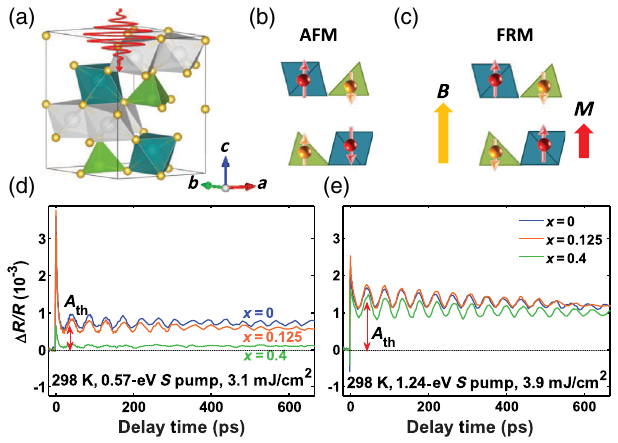
FIG. 2. (a) A schematic diagram of the unit cell of Fe 2 Mo 3 O 8 with Fe 2 þ ions in the green shaded oxygen octahedrons ( O site) and blue shaded oxygen tetrahedrons ( T site). The Mo 4 þ ions are located within the gray shaded oxygen octahedrons. (b),(c) Each illustration displays four sublattices in a magnetic basis for the AFM phase (b) and ferrimagnetic (FRM) phase (c). (d),(e) Time- resolved reflectivity change Δ R=R measured at room temperature with probe light centered at approximately 0.86 eV. The absorp- tion A (see text for the definition) is comparable for different Zn th Þ concentrations x in ð Fe 1 − Zn 2 Mo 3 O 8 when the pump photon x x energy is above 1 eV. However, A is greatly reduced with th excitation energies of approximately 0.5 – 0.6 eV for an x ¼ 0 . 4 sample, which replaces 80% of Fe 2 þ ions on the T site. The oscillatory behavior in Δ R=R is due to the Brillouin scattering of the probe light arising from a propagation of coherent acoustic strain generated by laser heating